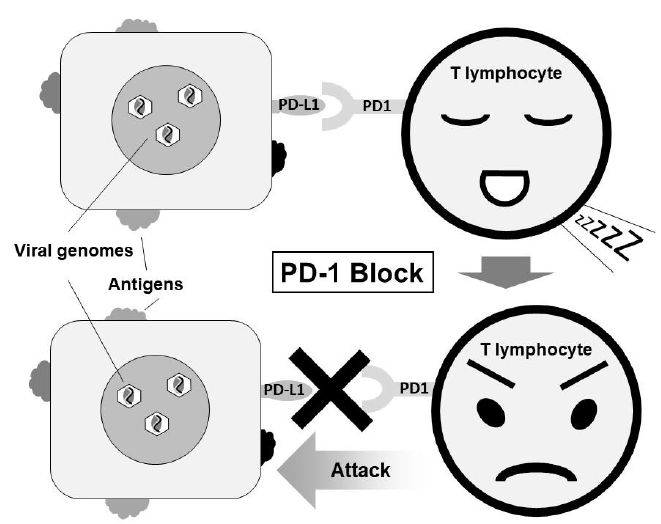
Figure 4. Treatment by blocking PD-1/PD-L1 for EBVaGC.